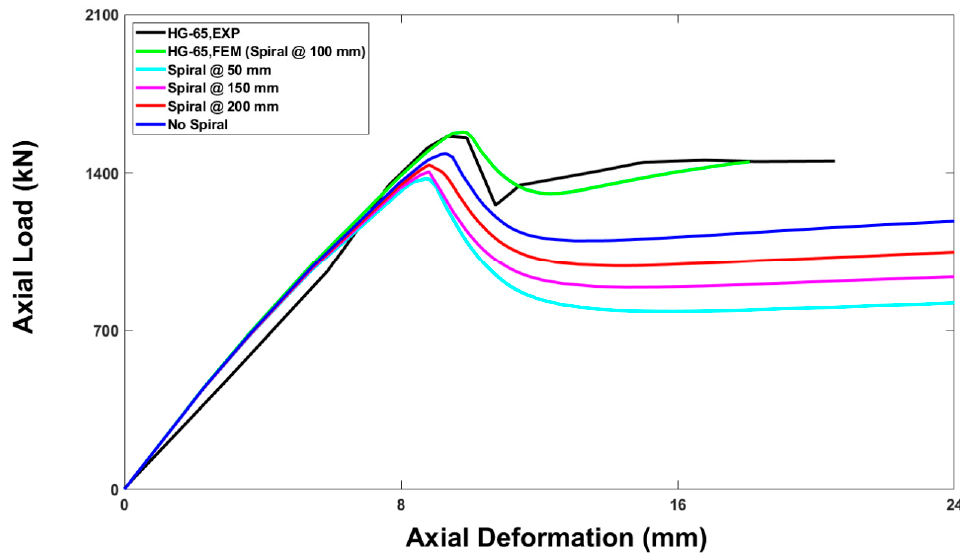
Figure 22. Effect of pitch of spiral